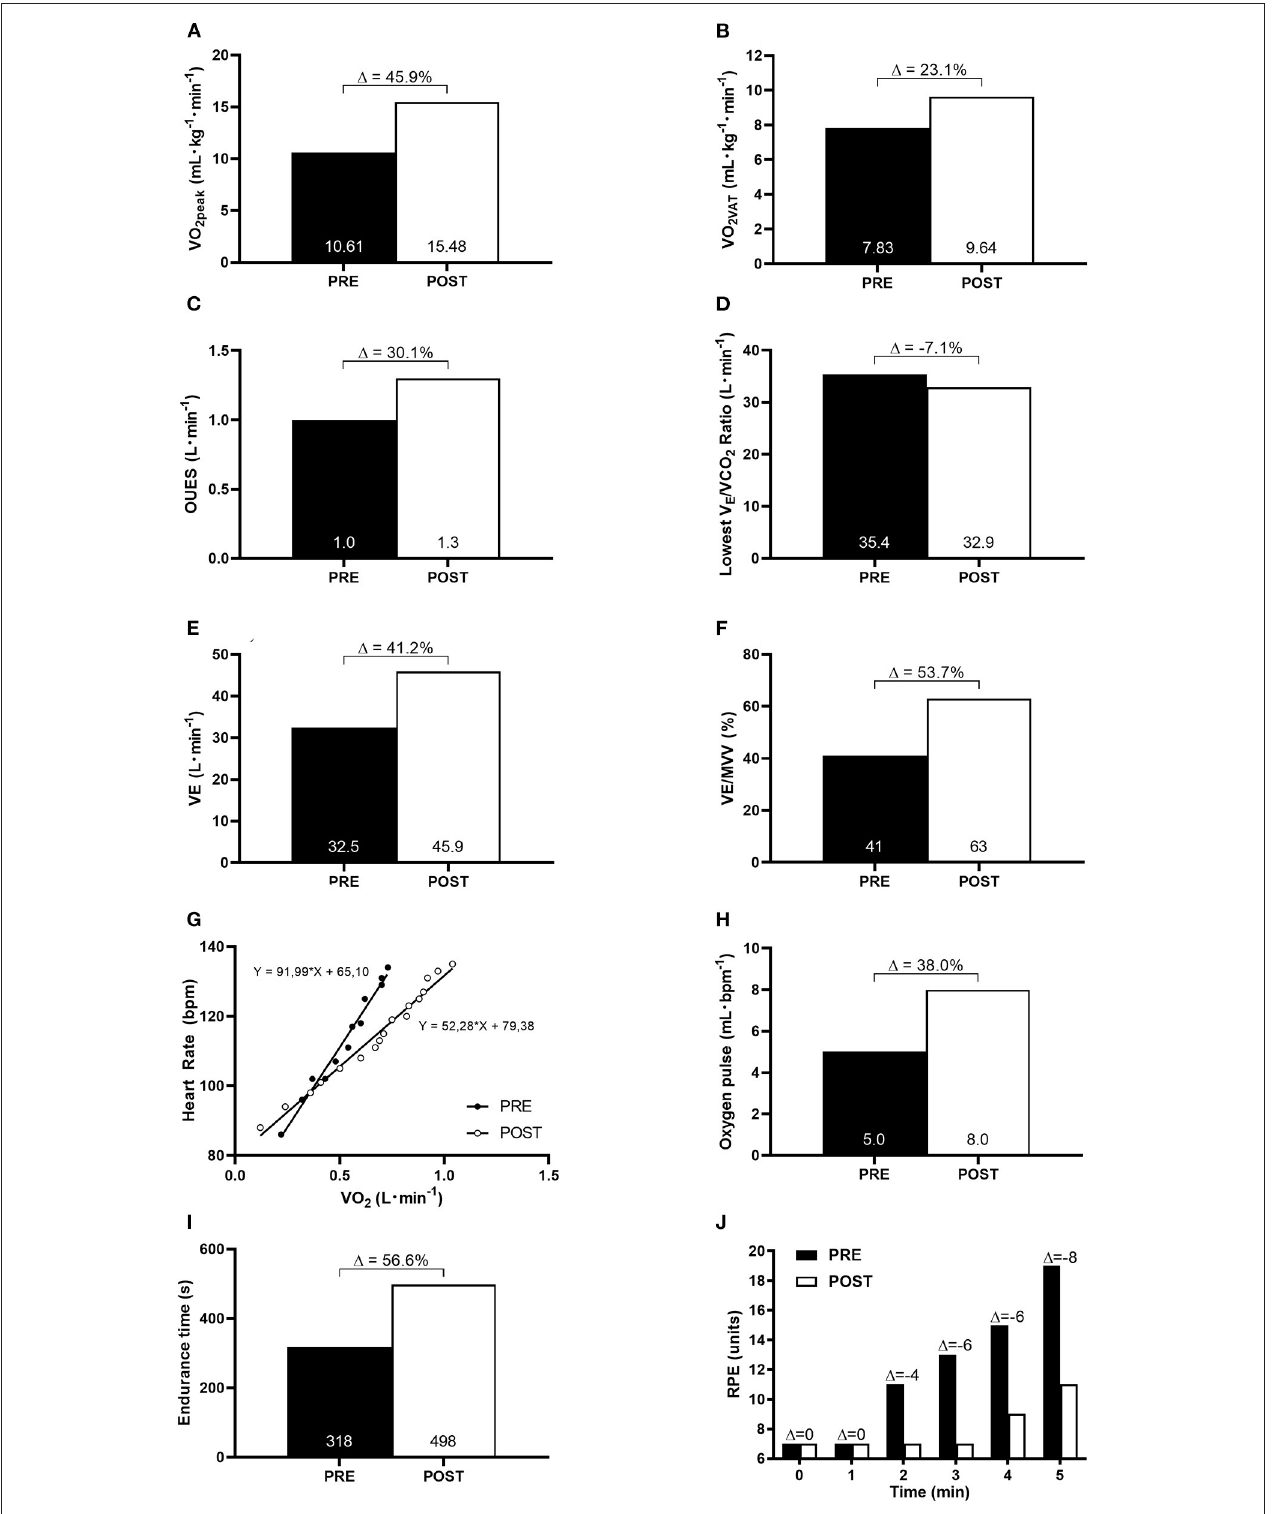
FIGURE 1 | Cardiorespiratory functional capacity at baseline (PRE) and after 10-week of HBET (POST). (A) peak oxygen consumption (VO 2peak ); (B) oxygen consumption at ventilatory anaerobic threshold (VO 2VAT ); (C) oxygen uptake efficiency slope (OUES); (D) the lowest V E /VCO 2 ratio; (E) ventilatory equivalente (VE); (F) ventilatory reserve (VE/MVV); (G) heart rate-oxygen consumption relationship (HR/VO 2 slope); (H) oxygen pulse; (I) endurance time; (J) isotime comparison of rate of perceived exertion (RPE) during incremental cardiopulmonary exercise test.